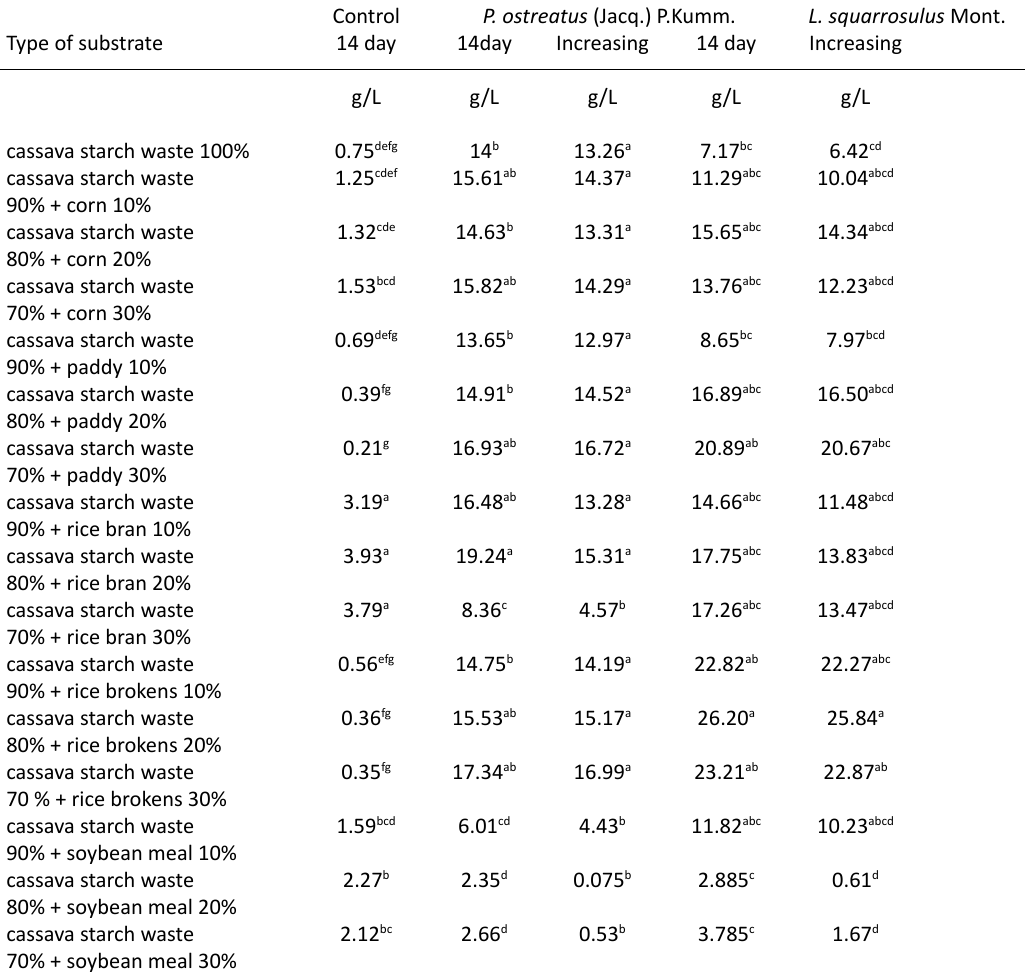
Table 1. Effect of P. ostreatus (Jacq.) P.Kumm. and L. squarrosulus Mont. on reduced sugar content at 14 days (g/L) Control P. ostreatus (Jacq.)